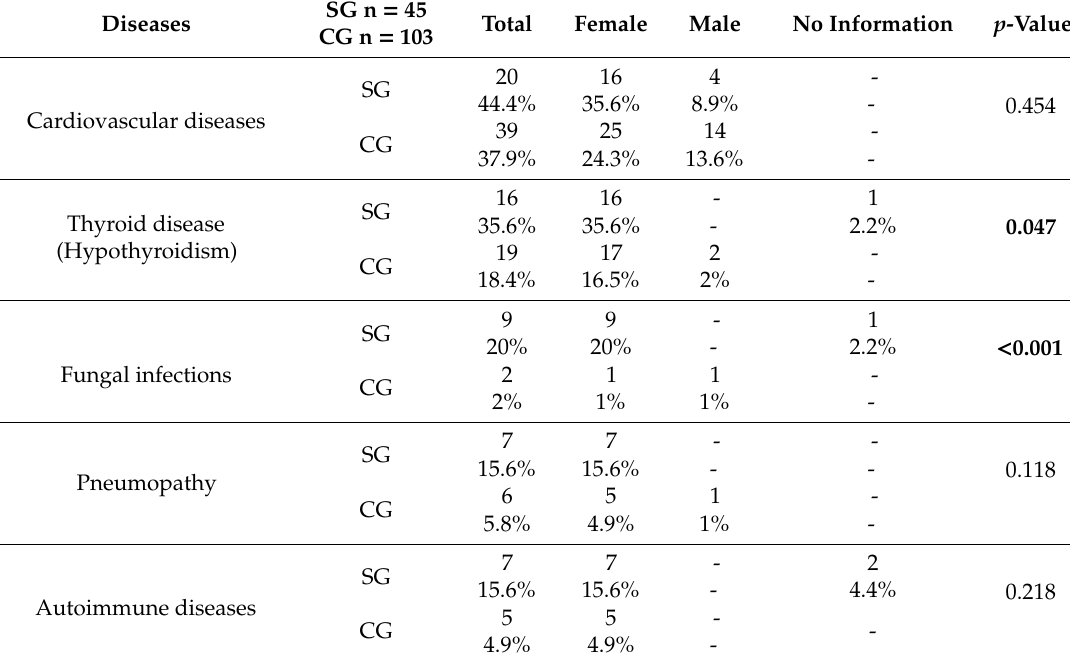
Table 3. Results of medical history (SG ... Study Group, CG ... Control